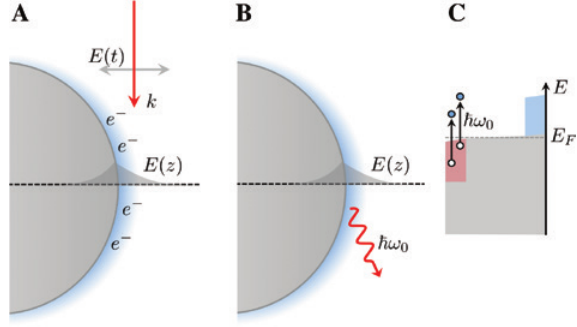
Figure 1: The driving and damping of a surface plasmon resonance